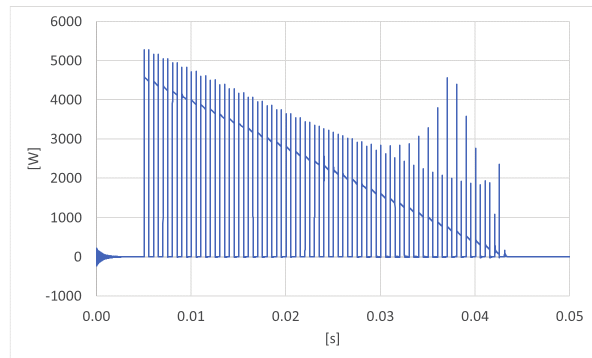
Fig. 7. Power dissipation on MOSFET.